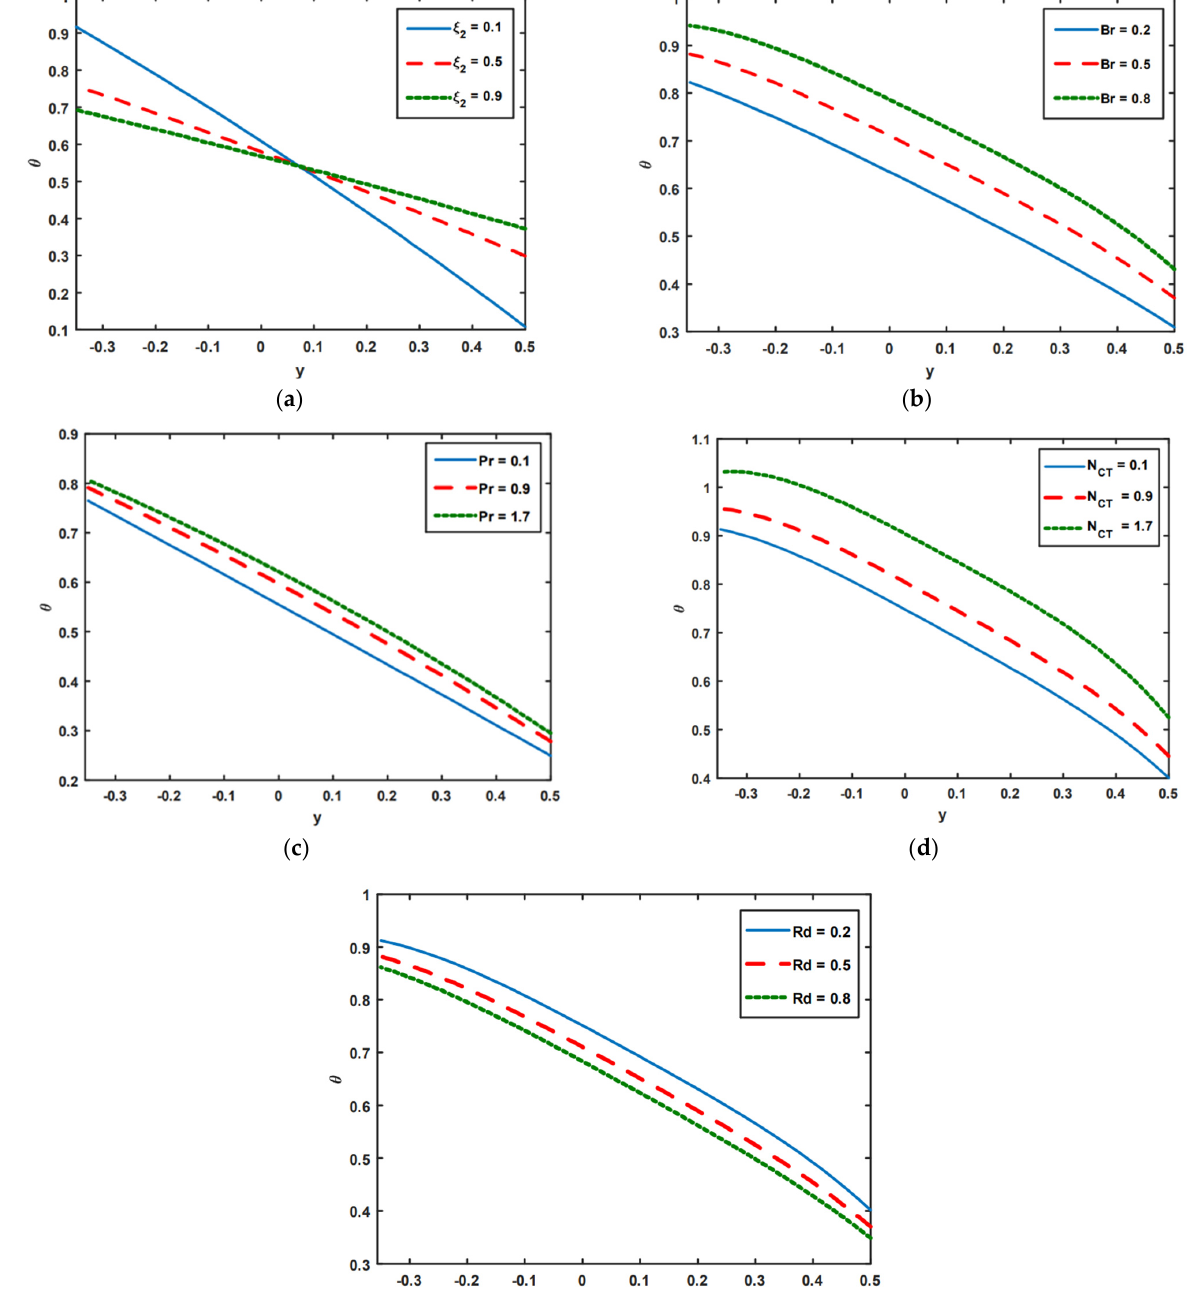
Figure 3. (a–d) Pressure gradient impact on 𝜉 (cid:2869) , 𝐺 (cid:3045)(cid:3007) , 𝐵𝑟 , and 𝑅𝑑 .